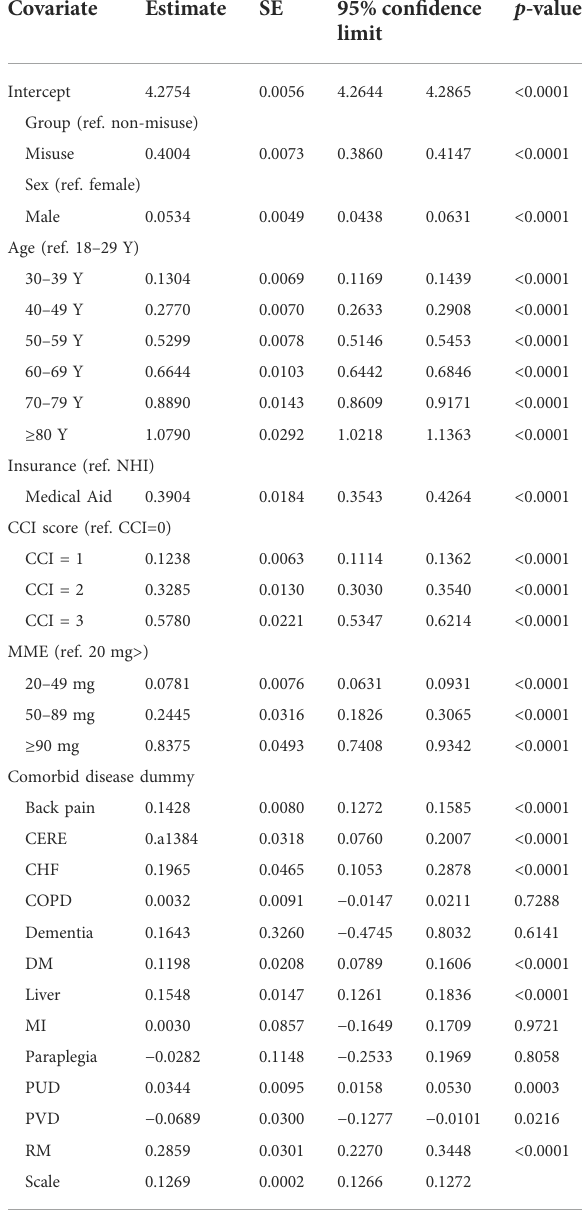
TABLE 3 Association between the direct medical cost and patient characteristics measured by GLM with the inverse Gaussian distribution and log link